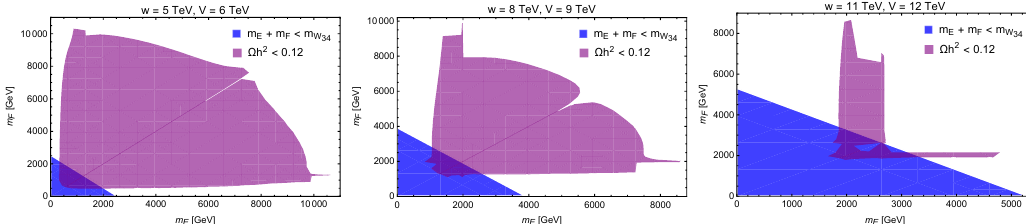
E ; m F ), where the dark matter